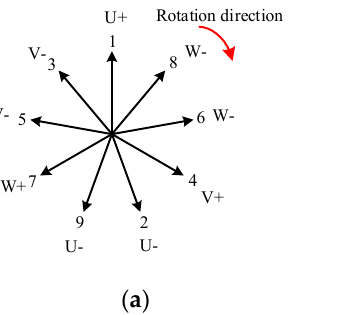
Figure 6. Winding connection. ( a ) For the fundamental component, 8-pole mode. ( b ) For the 3rd harmonic, 24-pole mode.